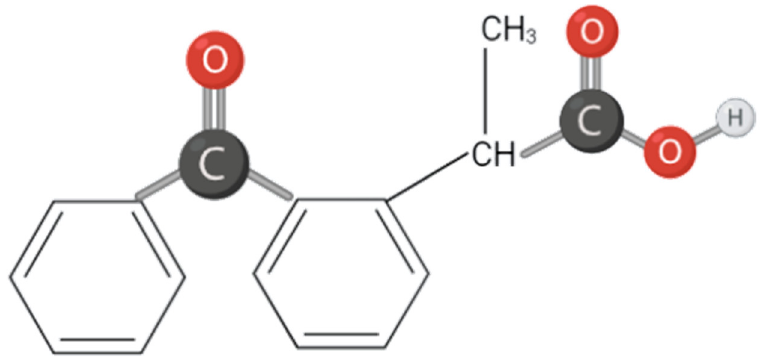
Figure 1. Ketoprofen structure. Arnica exerts anti-inflammatory, anti-microbial, antioxidant and